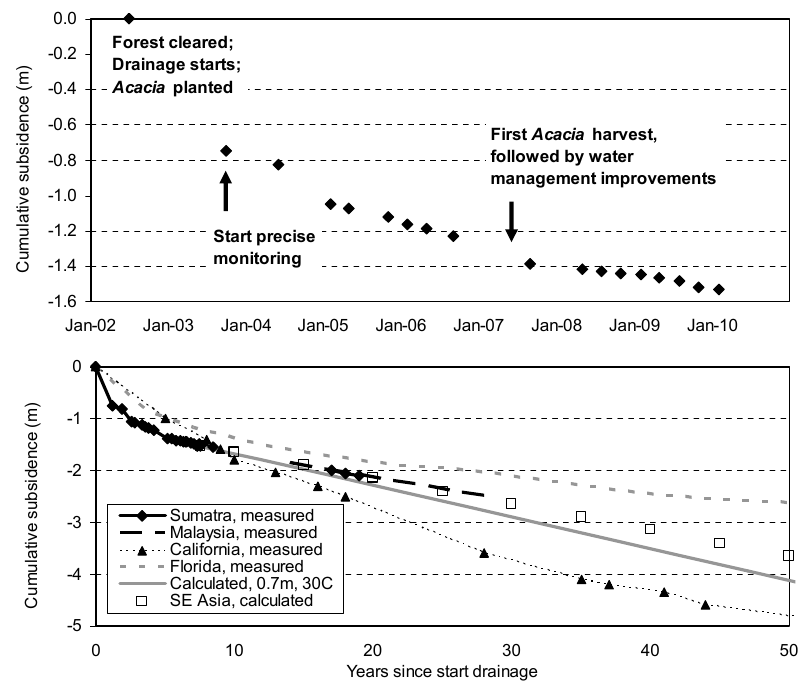
Fig. 4. Top: average subsidence rates as measured at 14 locations in Acacia plantations, over the first 9yr after drainage. Bottom: as measured at a larger number of drained peatland locations in Sumatra (this study), Malaysia (from W¨osten et al., 1997, based on DID Malaysia, 1996), Mildred Island in the California Sacramento Delta (Deverel and Leighton, 2010) and Florida Everglades. The Everglades record is averaged from three records presented by Stephens and Speir (1969); as the first two years after completing the drainage system in 1912 were missing from the subsidence record, which started in 1914, we added a subsidence of 22.5cmyr − 1 for those years, which is the average subsidence rate over 1914 and 1915 and therefore almost certainly an underestimate of actual initial subsidence. Also shown are long-term calculated subsidence rates for SE Asia, applying both the relation determined for Florida Everglades (Stephens et al., 1984), assuming a water depth of 0.7m and an average temperature of 30 ◦ C, and the relation found for SE Asia in this